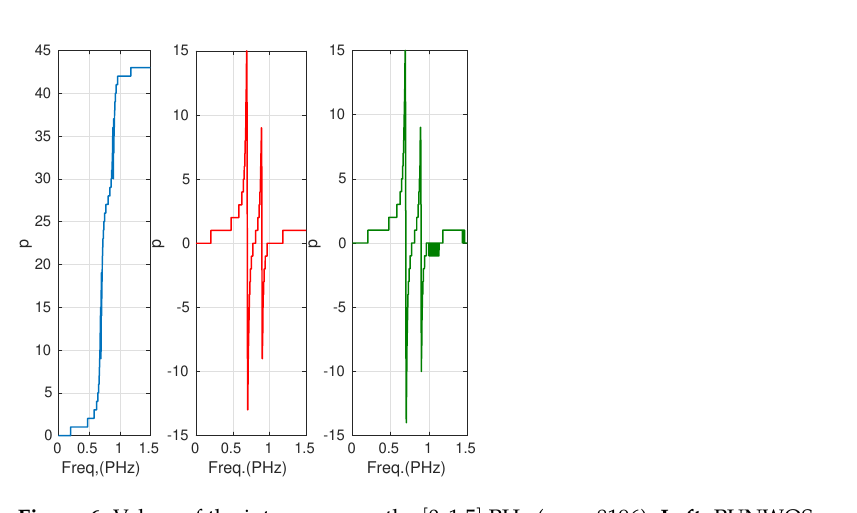
Figure 6. Values of the integer p over the [ 0,1.5 ] PHz ( n s = 8196). Left : PUNWOS; centre : PUNW HT ; right : PUNW KK